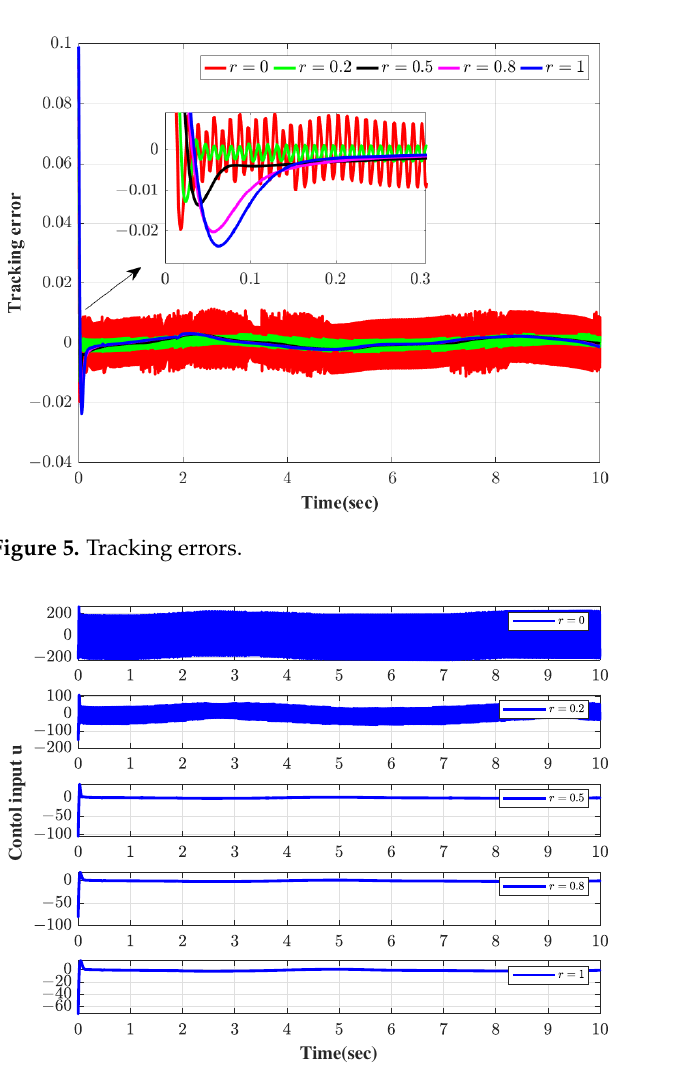
Figure 6. Control